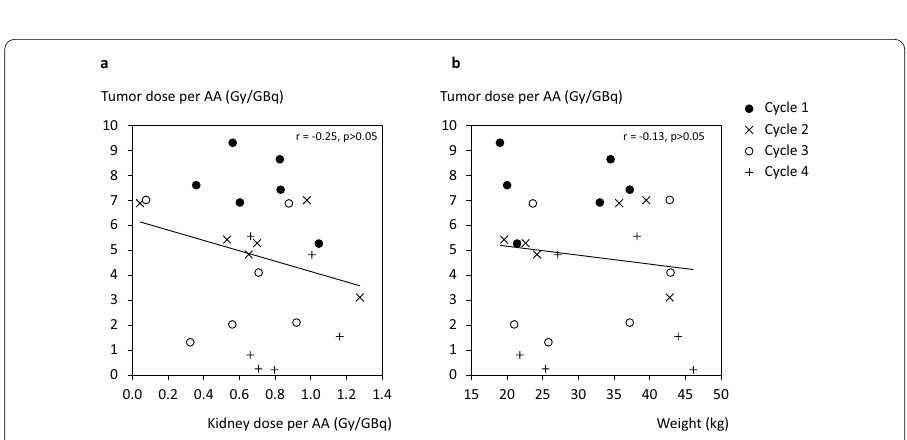
Fig. 3 Plot of tumour absorbed dose per unit AA (Gy/GBq) vs a the kidney absorbed dose per AA and b patient weight are shown as a function of individual treatment cycle. No correlation